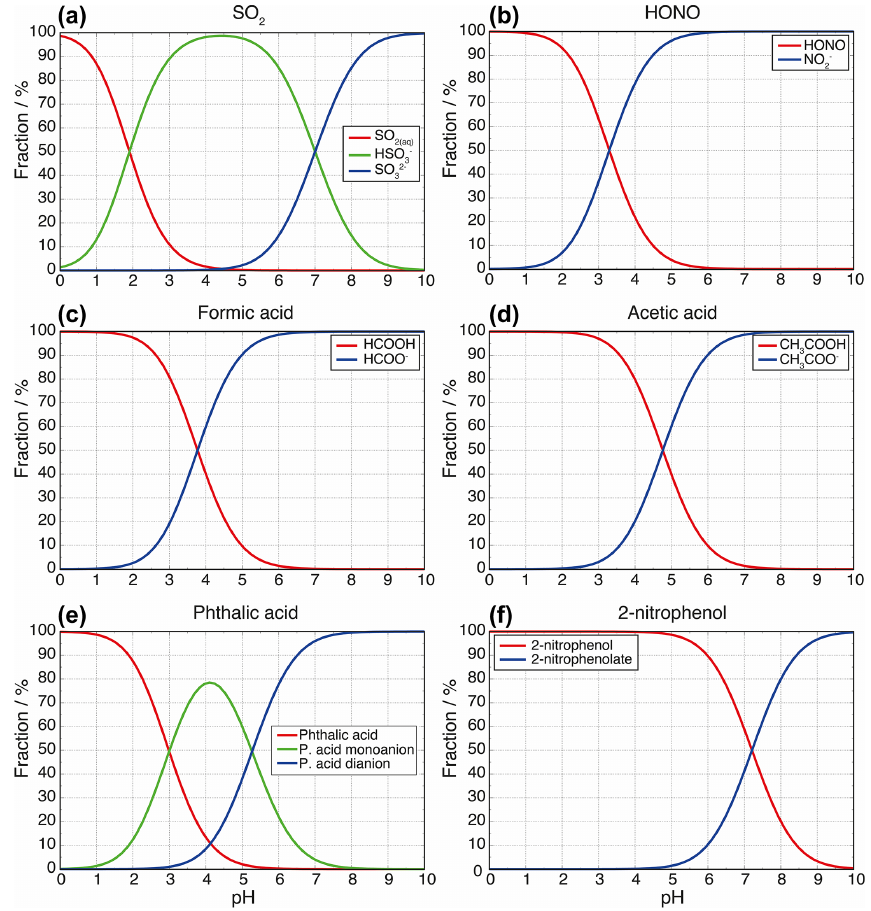
Figure 3. Ion speciation of dissolved (a) SO 2 , (b) HONO, (c) formic acid, (d) acetic acid, (e) phthalic acid, and (f) 2-nitrophenol as a function of